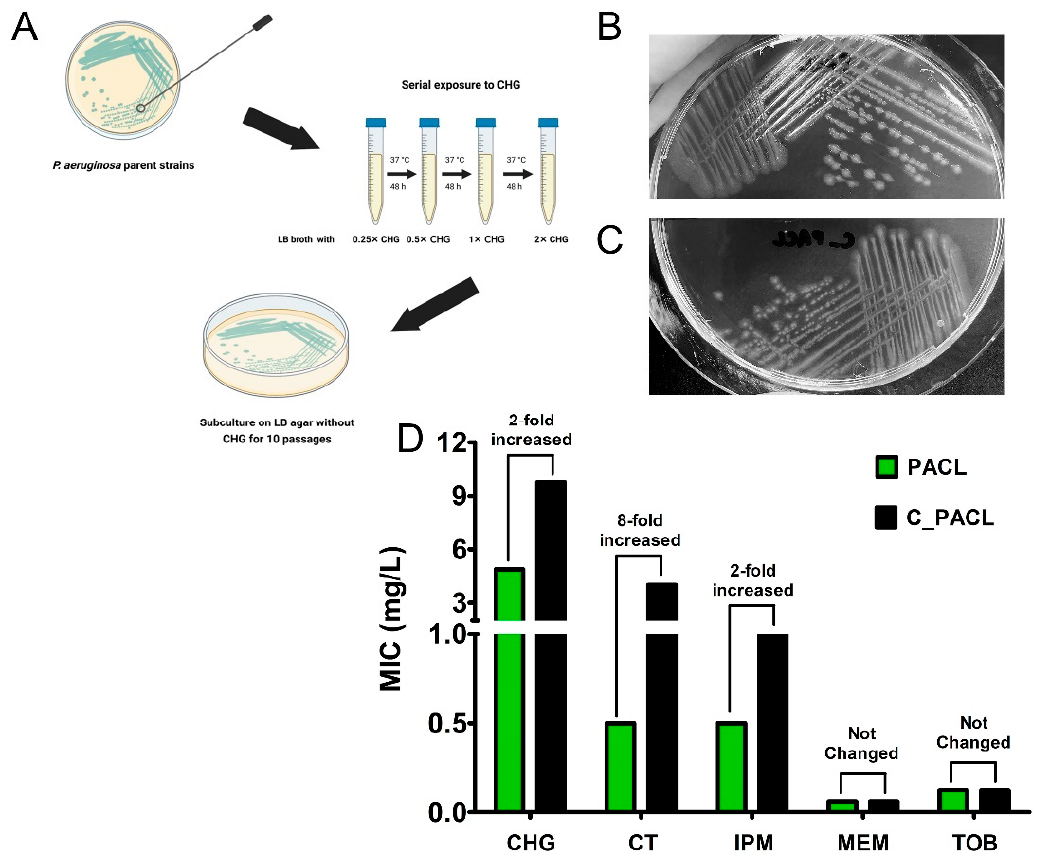
Figure 1. Diagram of Chlorhexidine (CHG) treatment protocol in P. aeruginosa clinical isolates demonstrates the subsequent increase in CHG concentrations during the treatment ( A ). The representative pictures of the colonies in CHG-free Luria-Bertani (LB) agar for 24 h at 37 °C of P. aeruginosa parent strain (PACL) ( B ) and CHG-treated strain (C_PACL) ( C ) indicates small colony variants (SCVs) in C_PACL. Minimal inhibitory concentrations (MICs) using broth microdilution method of PACL and C_PACL toward CHG and other antibiotics (CT: colistin, IPM: imipenem, MEM: meropenem, and TOB: tobramycin) are demonstrated ( D ). Triplicated independent experiments were performed.